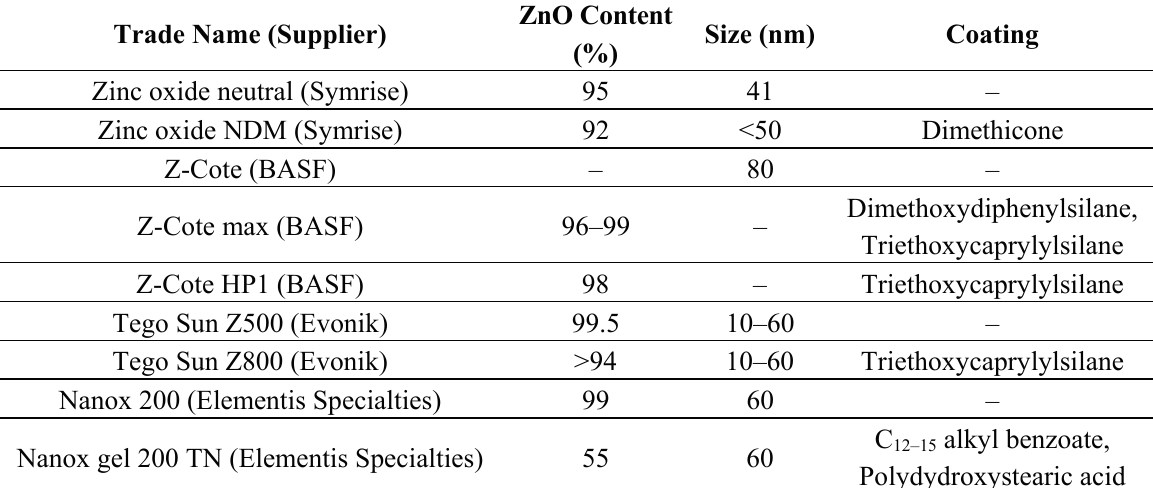
Table 5. Example of commercial forms of nanoparticle zinc oxide.